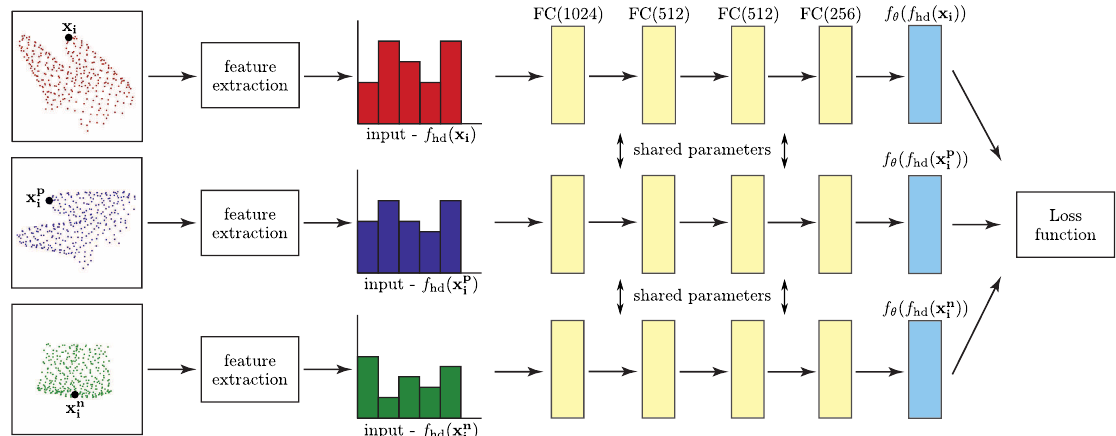
and negative example x n i are i